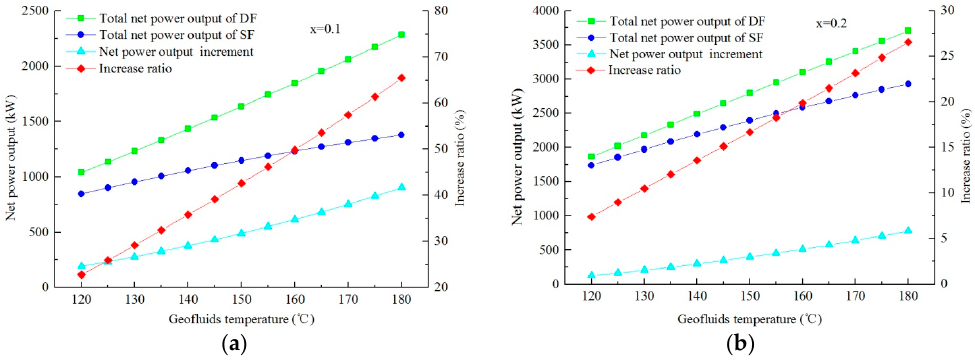
Figure 8. Variations of net power output of DF with geofluid temperature: ( a ) x = 0.1; ( b ) x = 0.2.